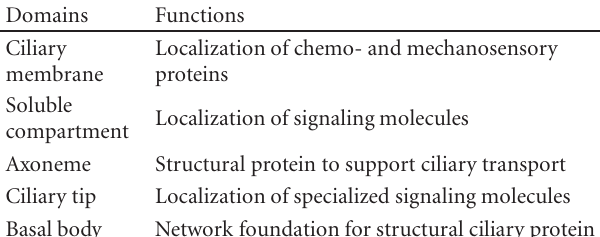
Table 2: Five distinct domains of a cilium.